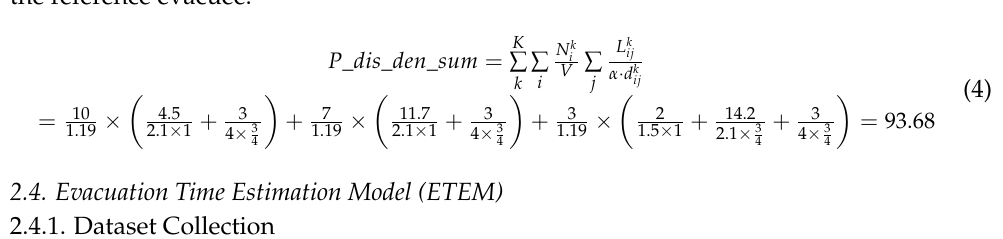
Figure 5. An evacuation scenario to describe the estimation of people distribution density. Formula (4) illustrates the calculation process of the people distribution density for the reference